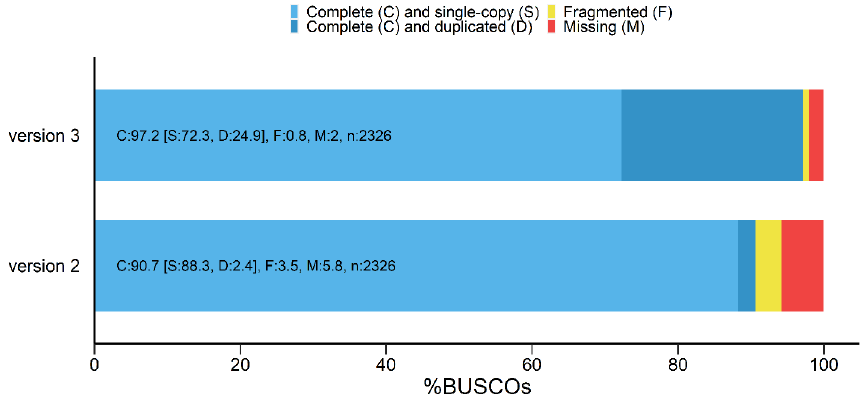
Figure 1. BUSCO scores of the predicted gene set. BUSCO: Benchmarking Universal Single-Copy Orthologs.